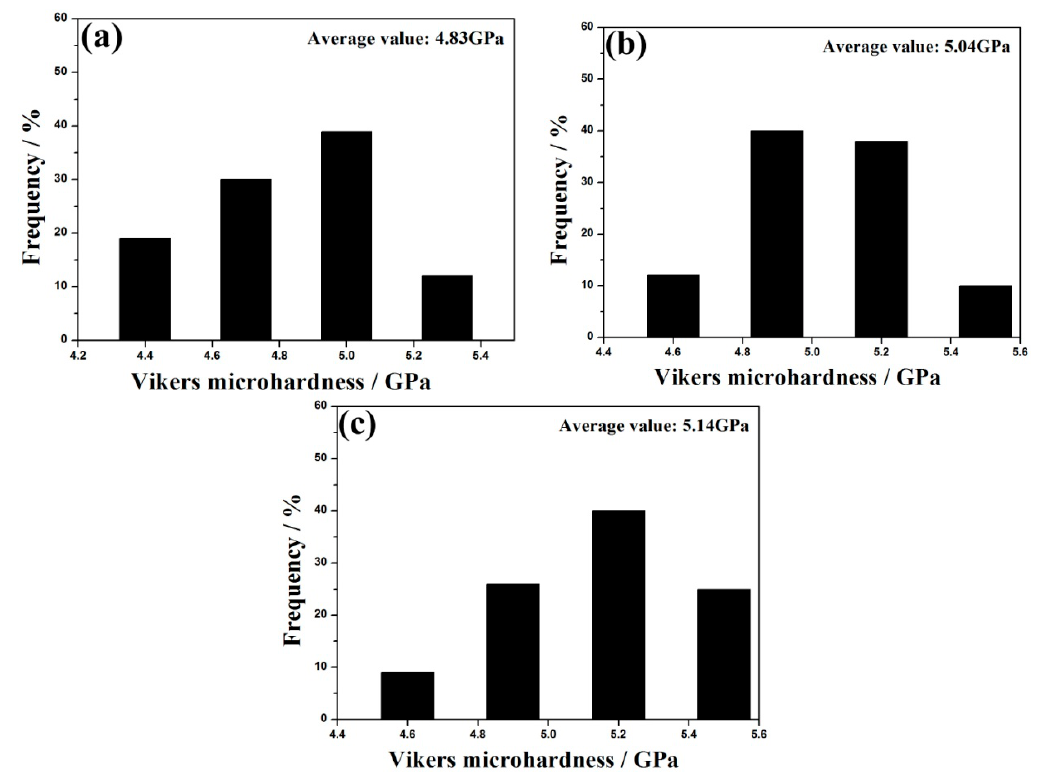
Figure 5. Vickers micro-hardness values of samples with different Mo content: ( a ) steel #1, Mo-free ( b ) steel 2#, 0.134 wt. % Mo, ( c ) steel #3, 0.273 wt. % Mo.